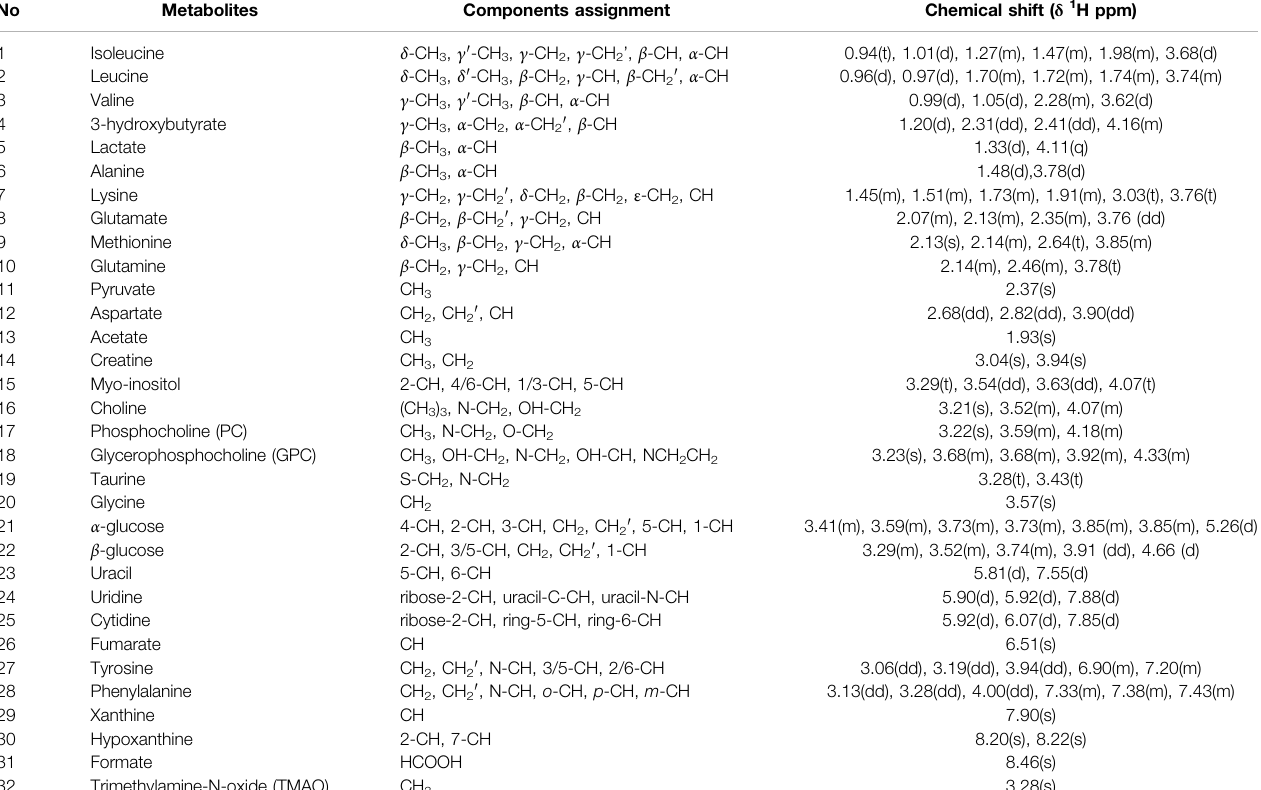
TABLE 2 | 1 H-NMR assignments of major metabolites from mice spleen